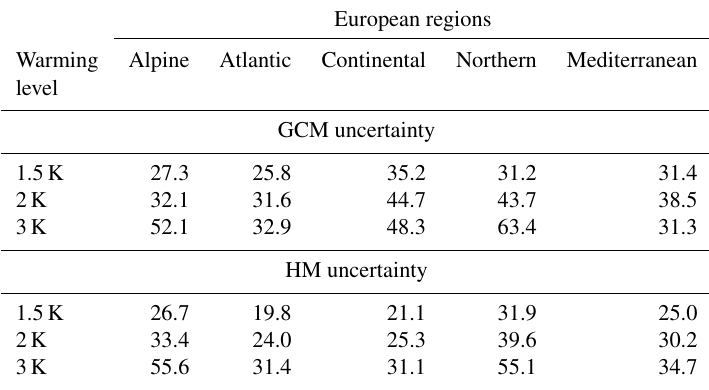
Table 4. Dimensionless uncertainty contribution of GCMs and HMs averaged over the stratified European regions described in Sect.